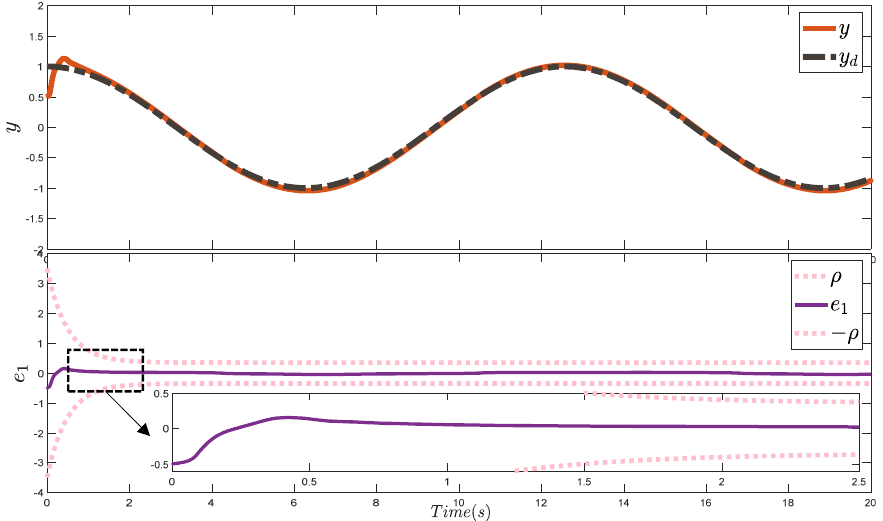
Figure 8. The output tracking performance y and error e 1 of the closed-loop